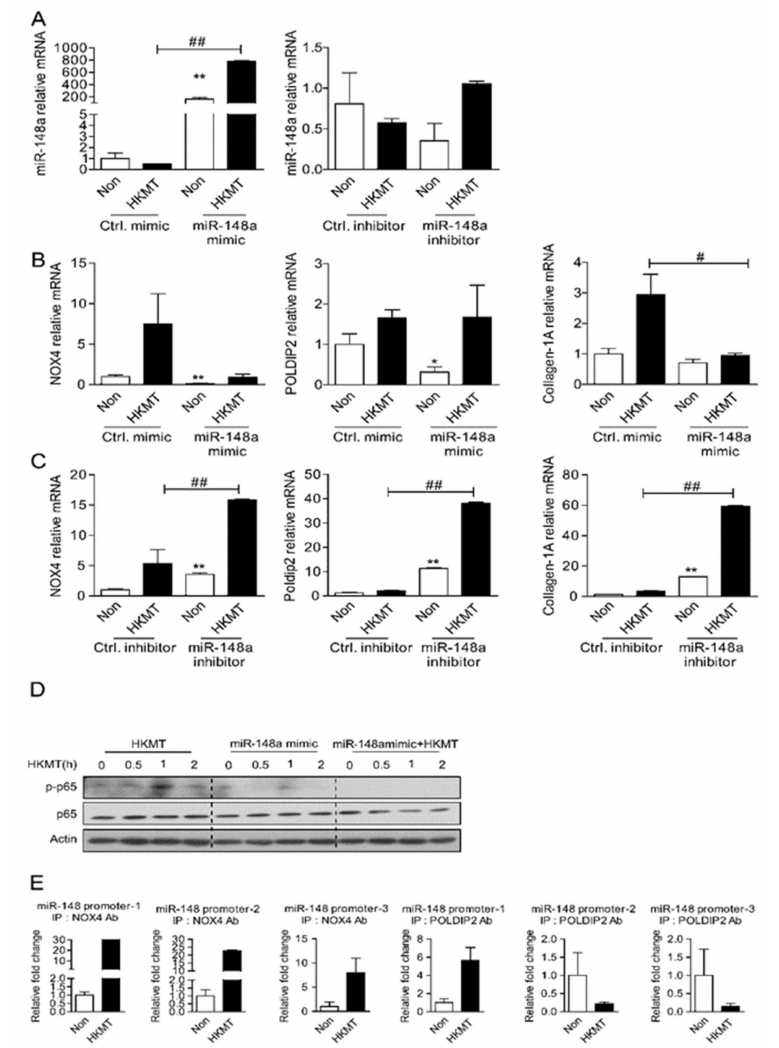
Figure 4. miR-148a can reduce tuberculous induced collagen-1A expression by regulating